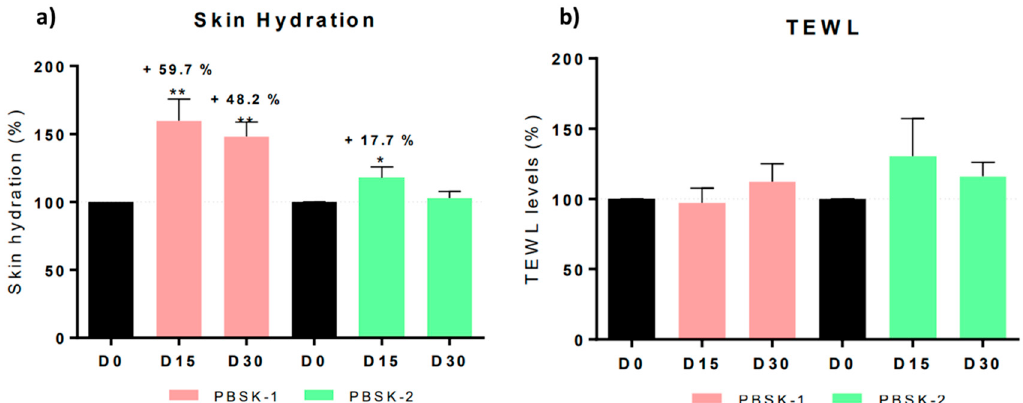
Figure 15. Graphical representation of skin hydration ( a ) quantified through Corneometer ® and TEWL ( b ) quantified through Tewameter ® , before (D 0 ), after 15 days of treatment (D 15 ) and after 30 days of treatment (D 30 ), with mask PBSK-1 or mask PBSK-2, in 30 human volunteers, comparing each volunteer with its own control at day 0. Statistical significances: * p < 0.05; ** p < 0.01.